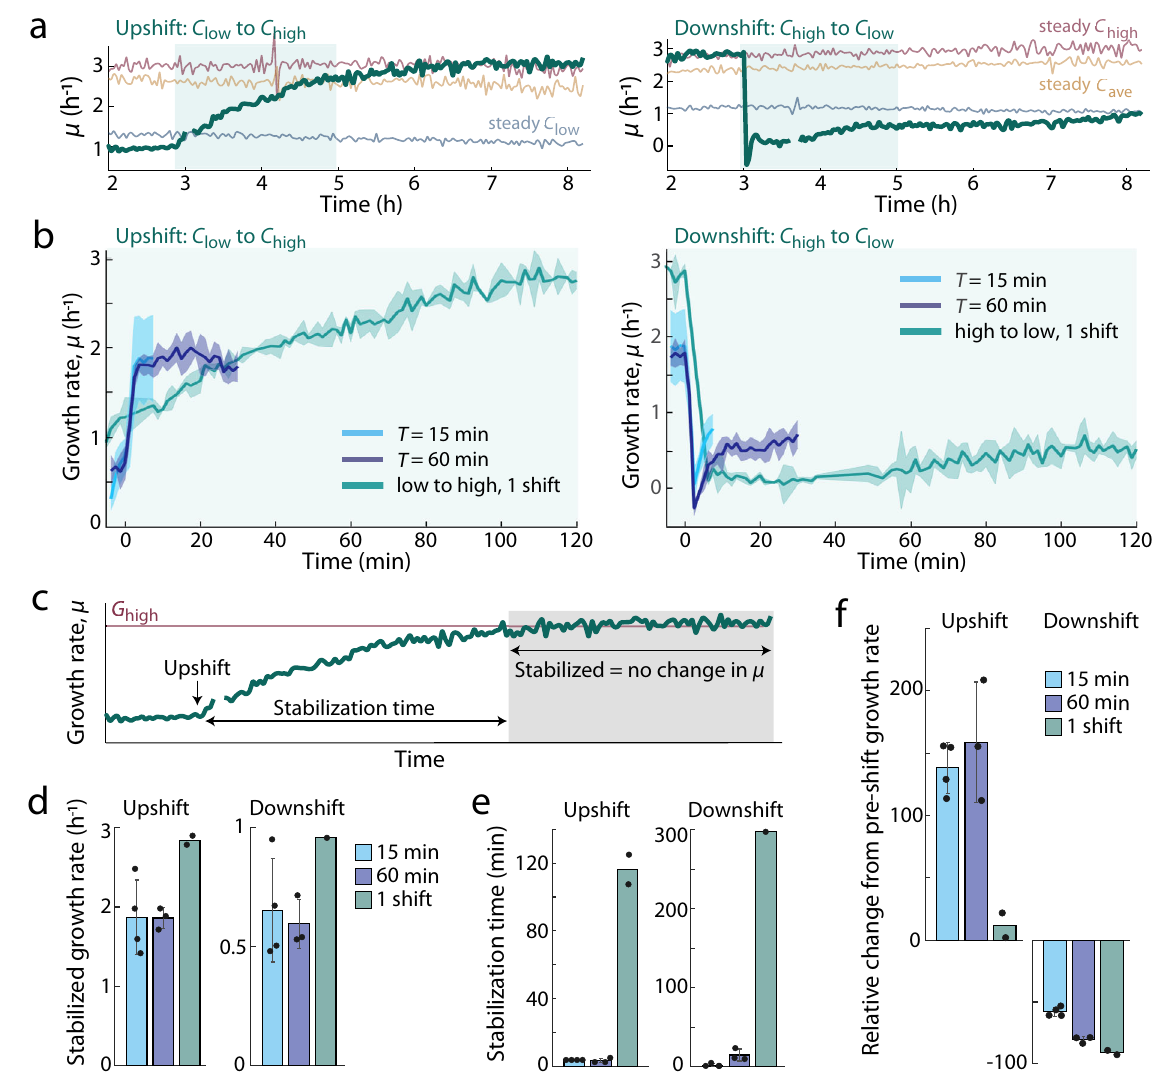
Fig. 4 Growth rate responses differ between repeated fl uctuations and single nutrient shifts. a Average growth rate of single cells over time in four conditions: a single shift in nutrient concentration (occurring at 3 h, after cells had reached steady-state growth in the initial condition), steady C low , steady C C C C C C ave and steady high . On the left, a single nutrient upshift (shift from low to high ), and on the right, a single nutrient downshift (from high to low ). After each shift, the growth rate gradually reaches steady-state growth in the post-shift condition. The growth rates in C low before the upshift and in the steady C G low condition are both within the range of measured steady-state low (Supplementary Tables 2 and 7). Data are from one representative experiment. The shaded region marks the portion of single-shift data plotted in ( b ), which does not include the full progression to steady-state growth after a single up- or downshift. b Growth rate of single cells in fl uctuating nutrient conditions stabilizes more rapidly and at a lower value when compared to the growth rate dynamics of cells experiencing a single shift. Data were aligned such that the nutrient shift in all conditions occurs at t = 0. Post-shift data in fl uctuating environments are plotted up until the next shift occurs. Shaded error bars denote the standard deviation of the mean among replicate experiments ( n = 3 – 4 for fl uctuating conditions; n = 2 for single-shift conditions). c Growth rate is considered stabilized once the slope of the growth signal within a shrinking window reaches zero. Stabilization time is de fi ned as the time between the nutrient shift and the time at which the growth rate is stabilized. d The growth rate of fl uctuation-grown cells stabilized at rates lower than steady-state G high or G low . Cells experiencing 15 and 60 min fl uctuations stabilized at 1.86 ± 0.47 and 1.86 ± 0.13 h − 1 , respectively, after an upshift and at 0.65 ± 0.22 and 0.60 ± 0.10 h − 1 after a downshift. Cells shifted once from steady-state stabilized only upon reaching steady state G high (2.84 ± 0.08 h − 1 ) after an upshift or G low (0.96 h − 1 ) when growth rate stabilized after a downshift (only one of two replicates stabilized at G low after 5 h of post-shift observation). e Cells grown in fl uctuations stabilize in growth rate within 3.8 ± 0.0 ( T = 15 min) or 3.3 ± 1.4 min ( T = 60 min) of each upshift and within 2.2 ± 1.9 ( T = 15 min) or 15.0 ± 7.6 min ( T = 60 min) of each downshift ( n = 3 – 4). Cells grown in steady environments stabilize hours after a single shift, 116.3 ± 12.4 min in the case of upshifts ( n = 2) and at least 297.5min after a downshift (one of two replicates stabilized after 5 h). f The initial change in growth rate in the minutes following a nutrient shift differed between cells experiencing fl uctuations and cells experiencing only a single shift. Over the fi rst 7.5 min after each upshift, cells experiencing fl uctuations increased in growth rate relative to their pre-shift growth rate ( t = 0) by 138.3 ± 20.6% (15 min) or 158.7± 48.4% (60 min), compared to a 12.0 ± 14.0% increase in the single-shift case. Over the 7.5 min after each downshift, cells experiencing fl uctuations decreased in growth rate by 57.8 ± 3.7% (15 min) or 80.4 ± 2.6% (60 min), compared to a 90.9 ± 2.5% decrease in growth rate in cells after a single shift. d – f Error bars denote the standard deviation of the mean of n = 3 or 4 biologically independent experimental replicates (none displayed for n < 3). Overlaid data points represent measurements from each of n replicates.